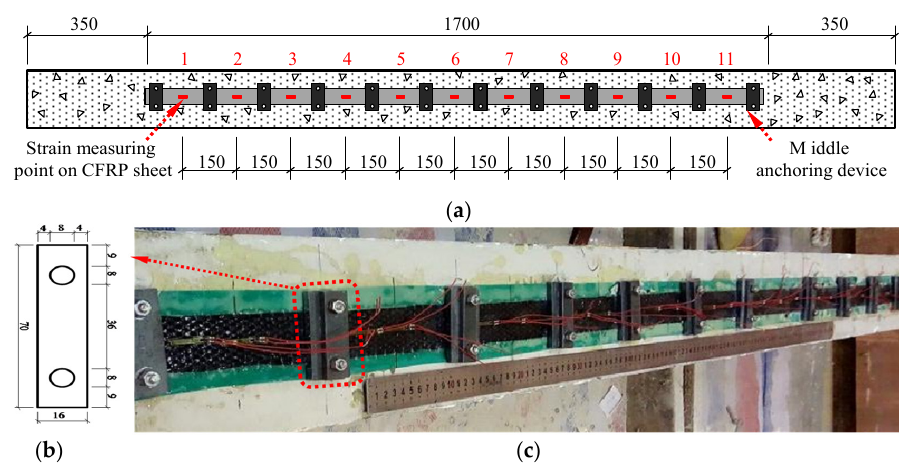
Figure 2. Middle anchoring of CFRP-reinforced specimens (dimensions in mm): ( a ) schematic diagram of middle anchoring and measuring point layout; ( b ) size of middle anchoring device; ( c ) middle anchoring test diagram.